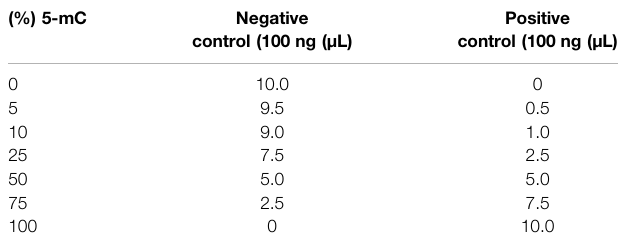
TABLE 1 | Standard curve for % 5-mC